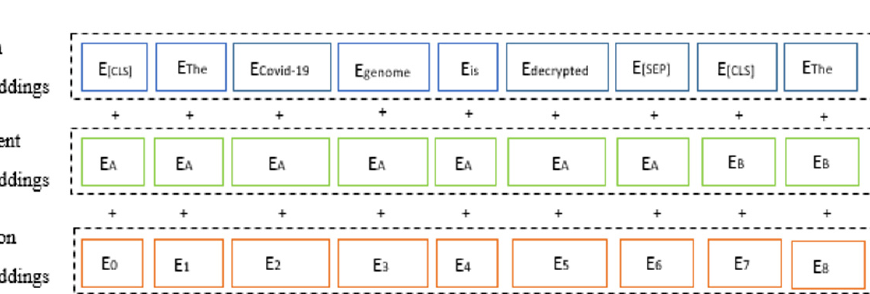
Figure 2. BERT-base fine-tuning model architecture: COVID-19 case study.